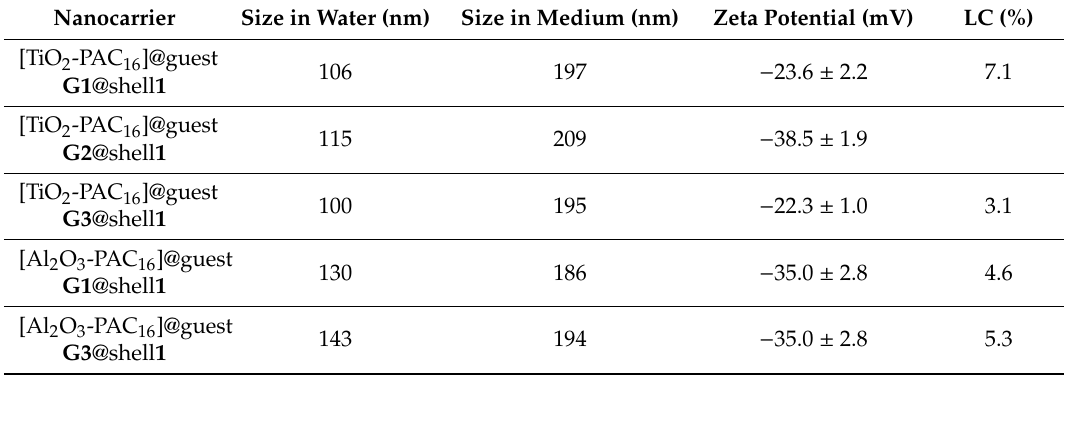
Table 1. Summary of the hydrodynamic diameter, zeta potential and loading capacity (LC) of the Shell-by-Shell (SbS) coated nanocarrier assemblies that are loaded with guest molecules G1 (quercetin), G2 (7-amino-4-methylcoumarin), and G3 (perylendiimide). Nanocarrier